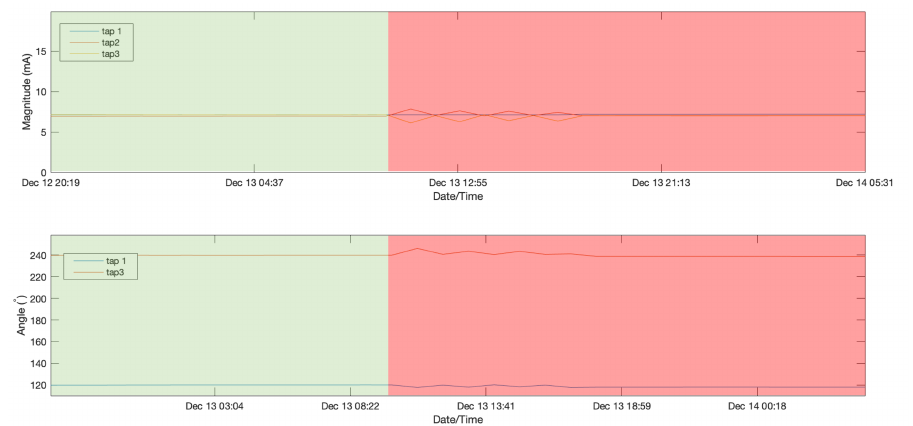
Figure 8. Magnified anomaly detection result on magnitude and angle data in experiment 1.